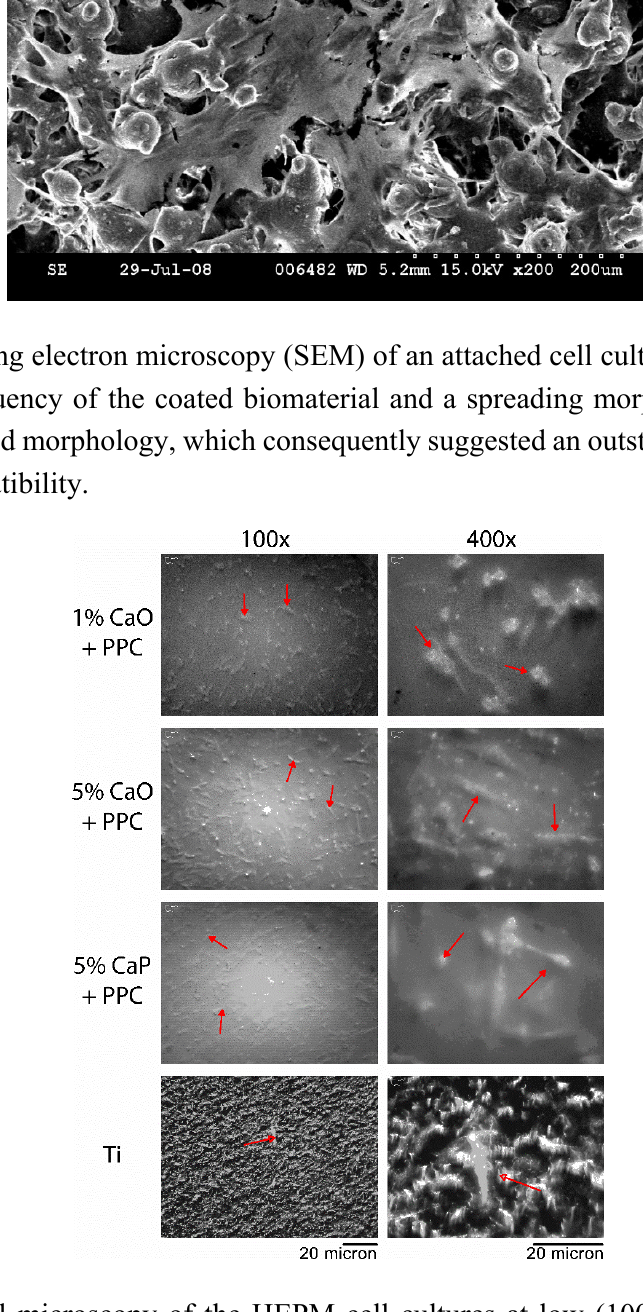
Figure 9. Optical microscopy of the HEPM cell cultures at low (100×) and high (400×) magnifications. Optical microscopy suggested that all of biomaterials were able to support HEPM cell cultures. However, under lower power (100×), the images suggested that the cellular confluence correlated with the incorporation of calcium oxide. While at high magnification (400×), a spreading morphology was observed on all of the surfaces, indicating the close association between the cells and their underlying substrate. The arrows are placed to help locate the cells on each surface. (Adapted and modified from